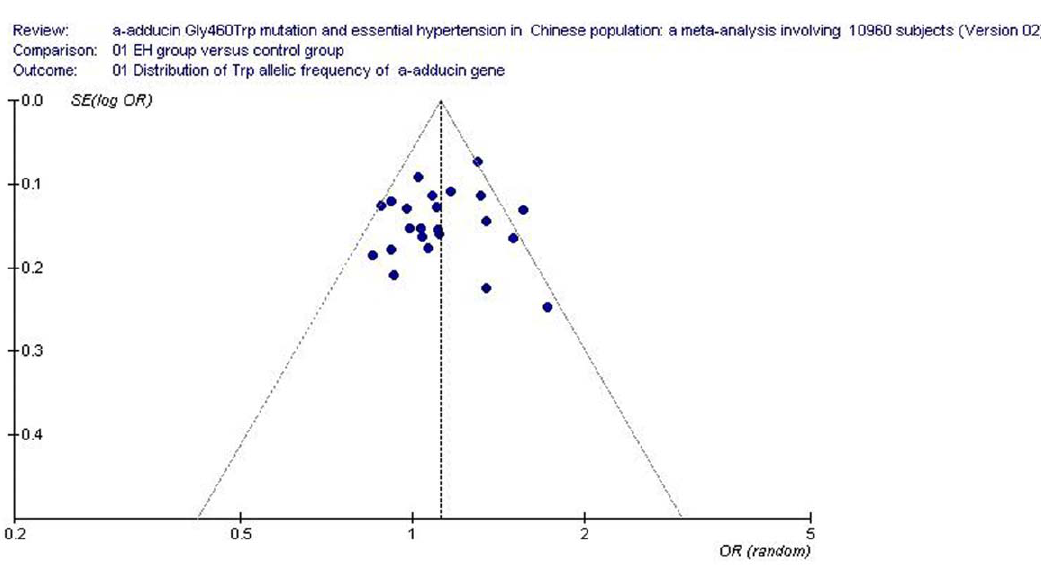
Figure 10. Funnel plot for studies of the association of essential hypertension and a -adducin Gly460Trp gene polymorphism under an allelic genetic model (distribution of Trp allelic frequency of a -adducin gene). The horizontal and vertical axis correspond to the OR and confidence limits. OR: odds ratio; SE: standard error.